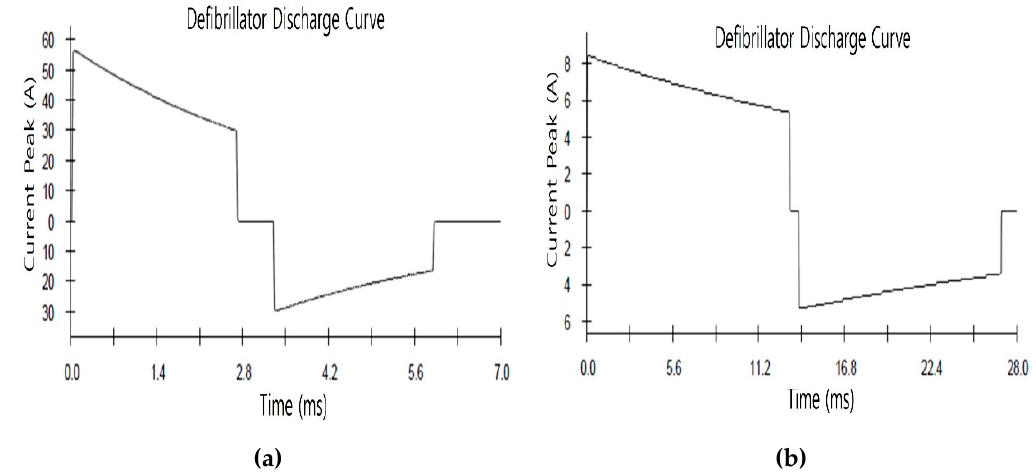
Figure 3. Adult mode of peak current: ( a ) 25 Ω Adult mode of peak current, ( b ) 175 Ω Adult mode of peak current.